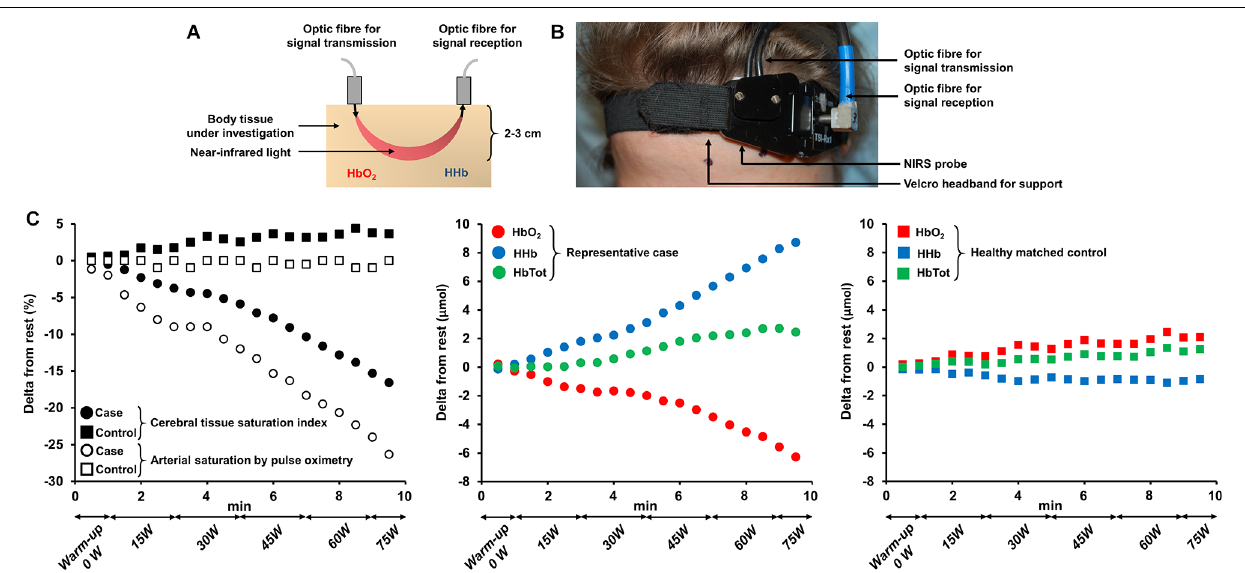
FIGURE 2 | Principles of near-infrared spectroscopy technology (panel A ), experimental setting for assessing cerebral oxygenation at the prefrontal cortex (panel B ) and time-course changes in prefrontal cortex hemodynamics in a representative patient with severe activity-related hypoxemia and a healthy matched control (panel C ). (A,B) Near-infrared light illuminates the tissue under investigation and is reflected back to the receptors. The technique allows the determination of the concentration of two main chromophores: oxy- and deoxyhemoglobin. Near-infrared spectroscopy is typically suitable for the investigation of cerebral